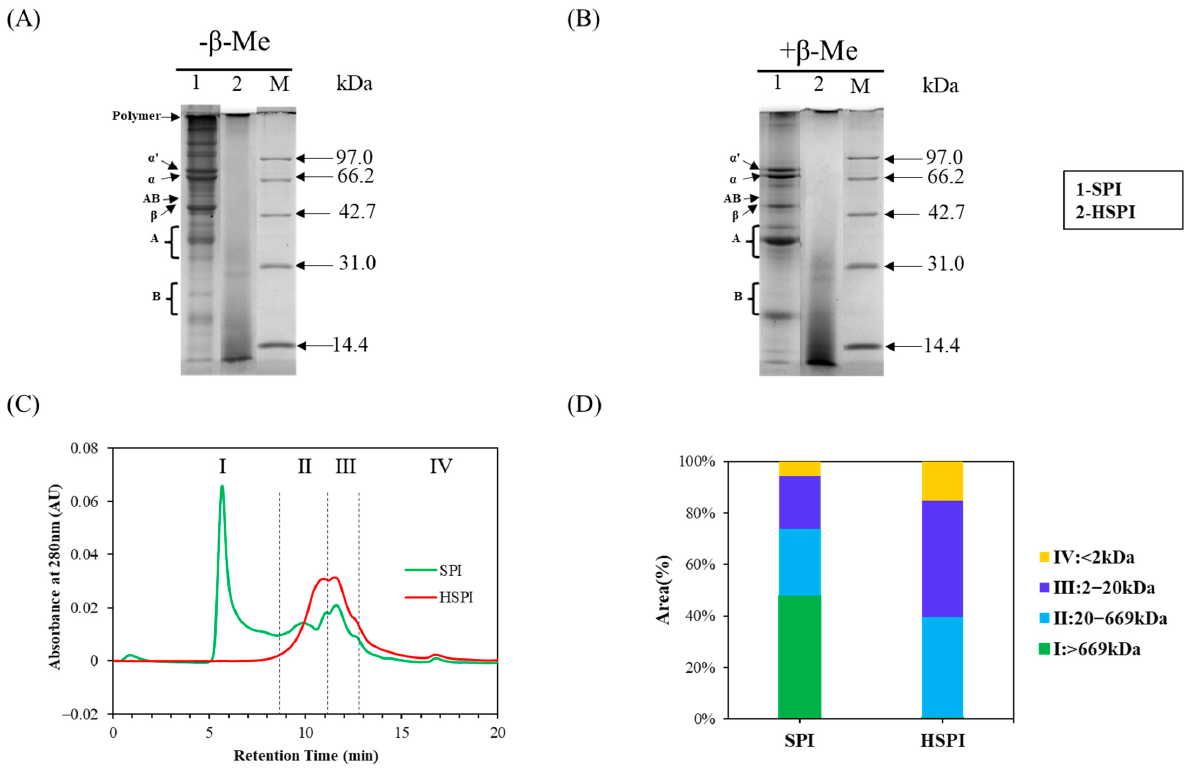
Figure 2. Non-reduced ( A ) and reduced pattern ( B ) SDS-PAGE profiles of SPI (Lane 1) and HSPI (Lane 2). M: molecular weight marker (kDa), β− Conglycinin: α ’ (86 kDa), α (66 kDa), and β (51